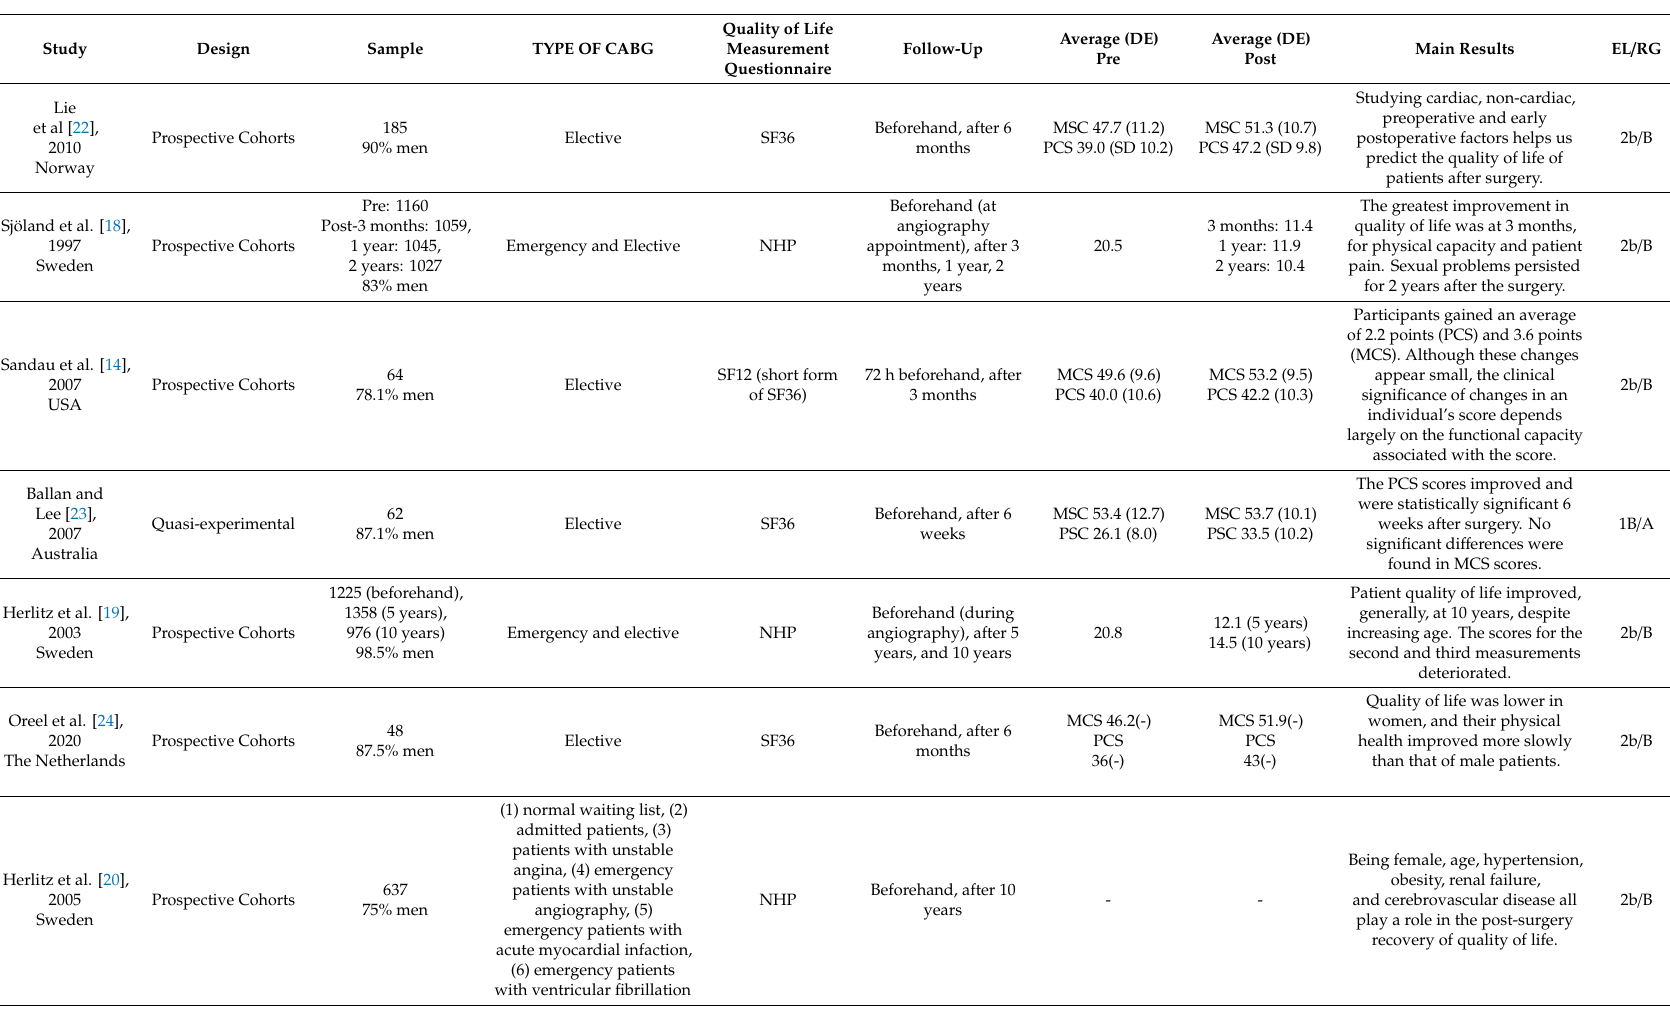
Table 1. Characteristics of the included studies ( n =